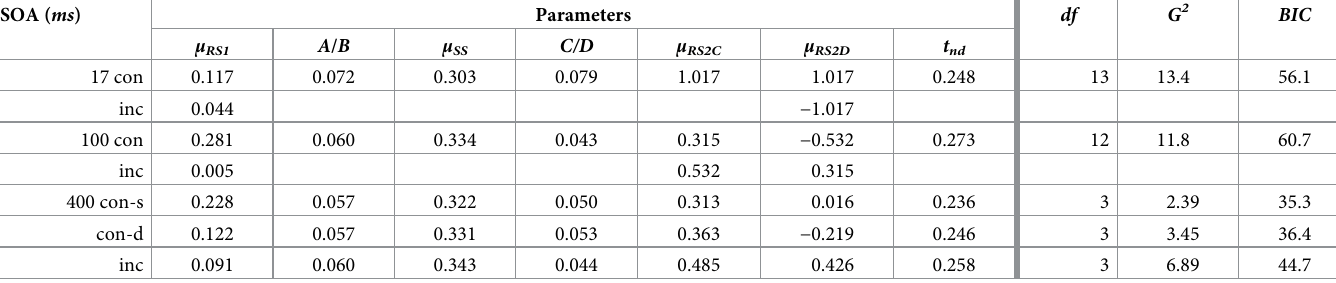
Table 2. Parameter estimates obtained by fitting the DSTP model to the distributional data of the different conditions in Experiment 2. SOA ( ms )